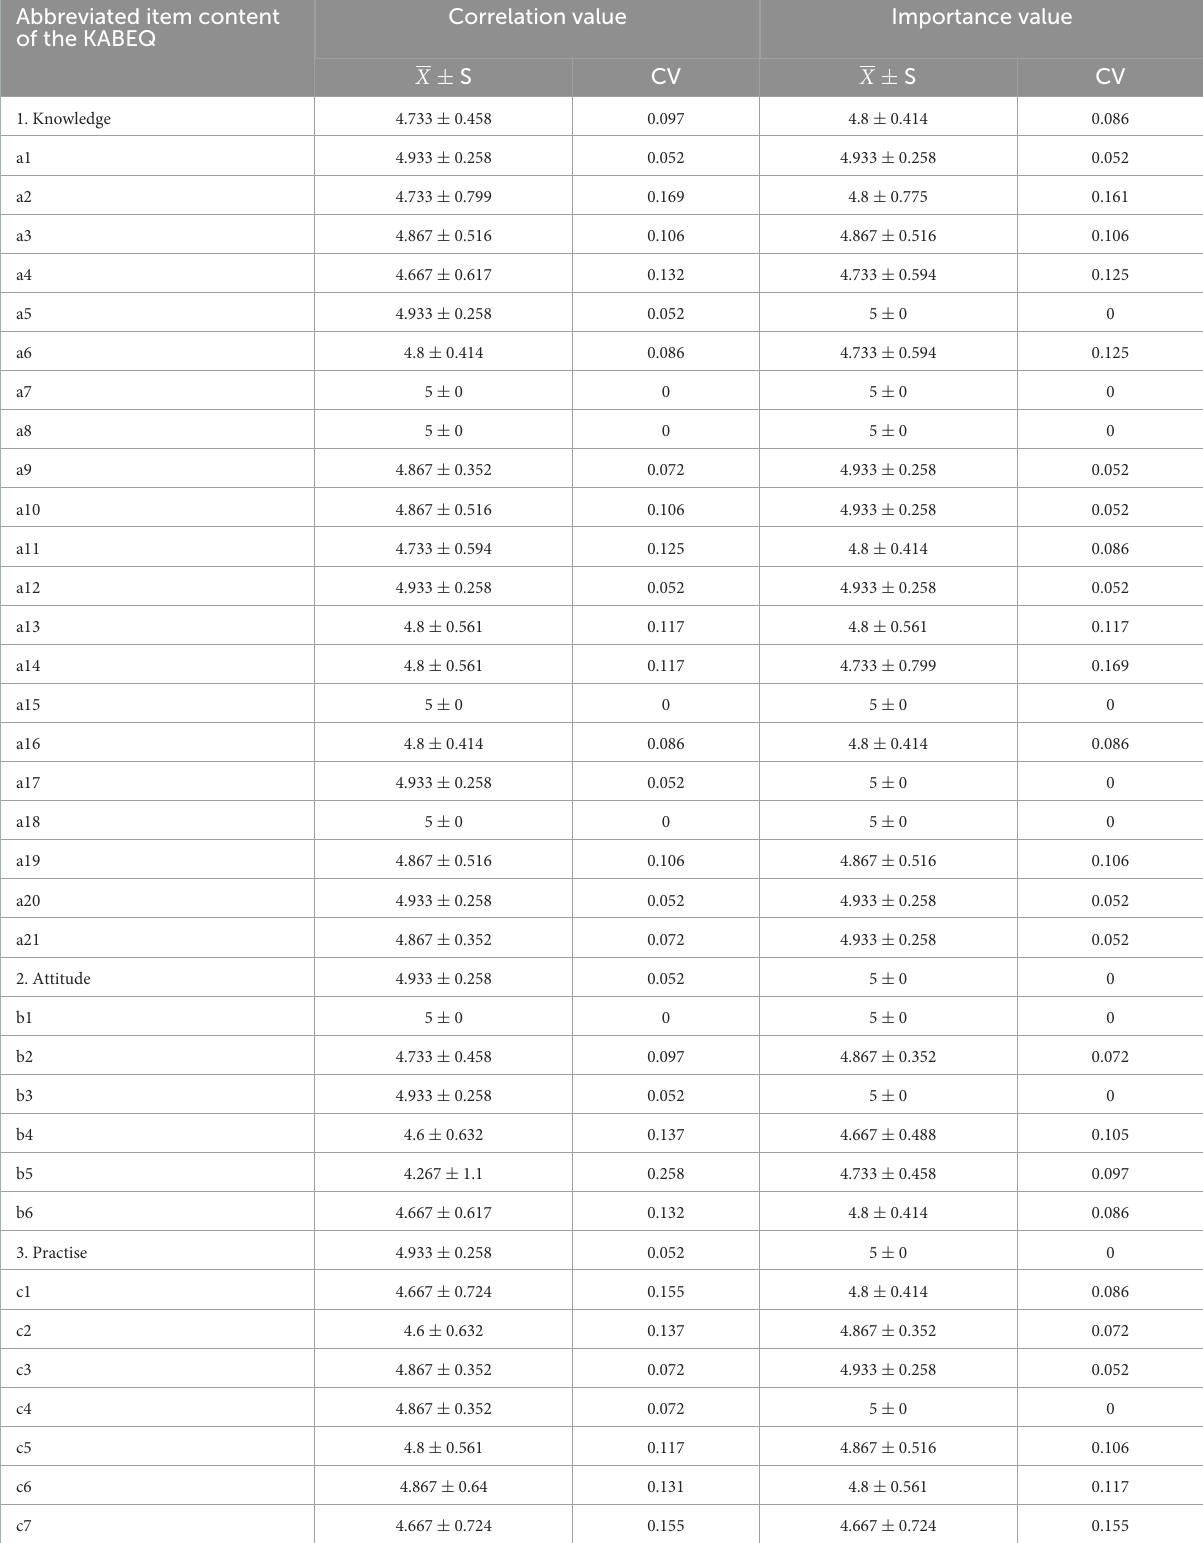
TABLE 2 Results of Delphi round 1 ( N =